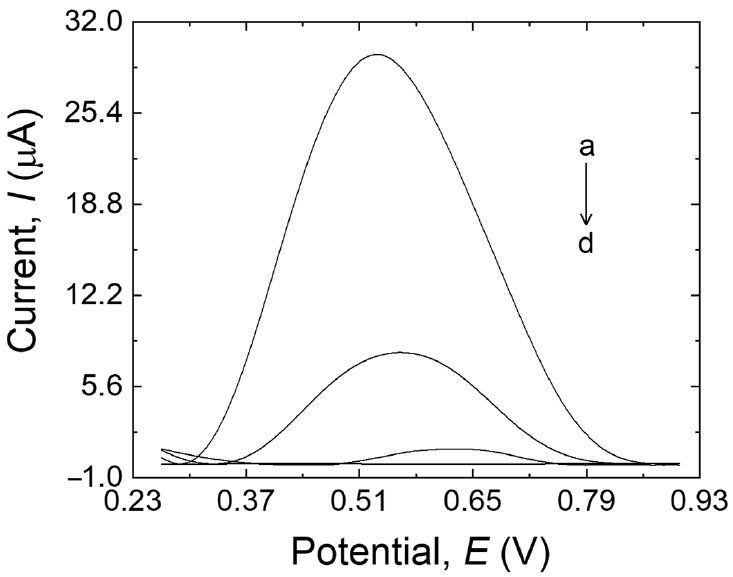
Table 1. Comparison of the electrocatalytic oxidation peak current ( I p ) of MDA (500 µM) on various electrode surfaces at pH 10.0.